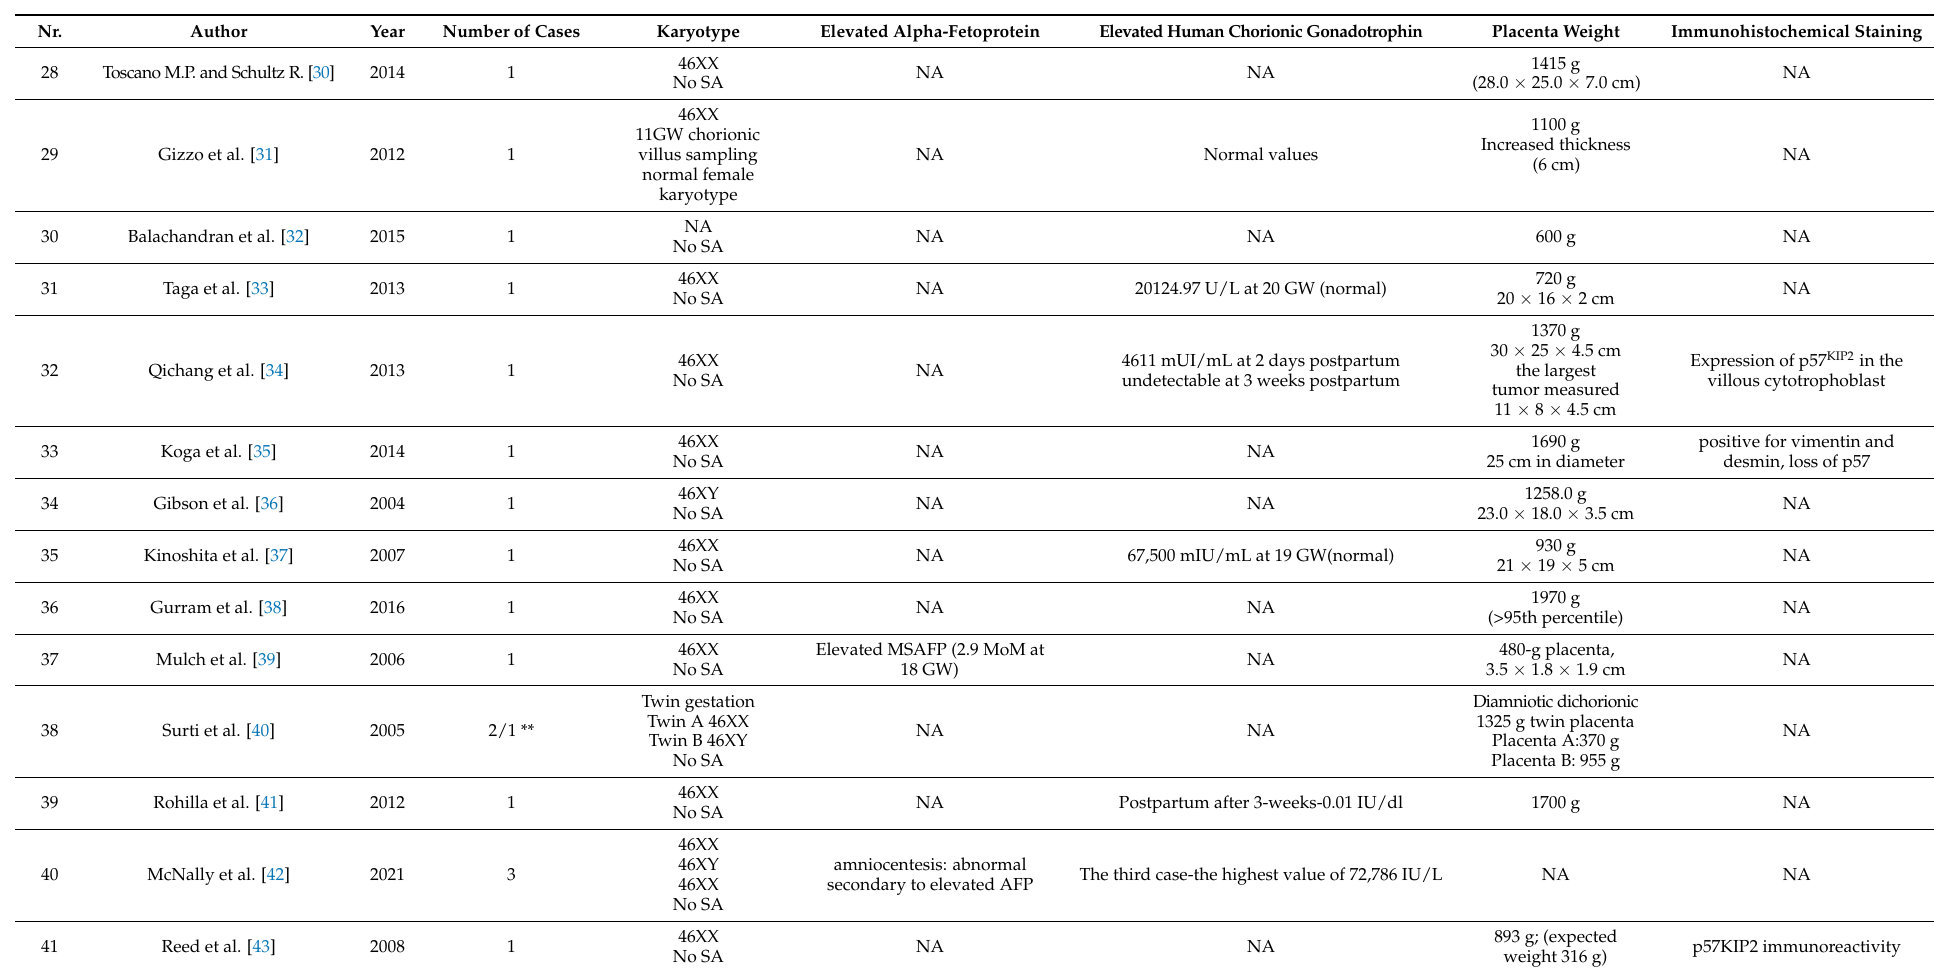
Legend 1. SA—specific abnormalities, NA–not available, MoM—multiple of the median, GW—gestational weeks, PAPP-A—pregnancy-associated plasma protein A; * the total number of healthy newborns among all reported cases of placental mesenchymal dysplasia, by the respective author; ** total number of healthy newborns from twin pregnancies with placental mesenchymal